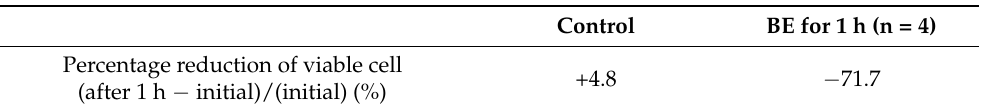
Control BE for 1 h (n = 4) +4.8 −